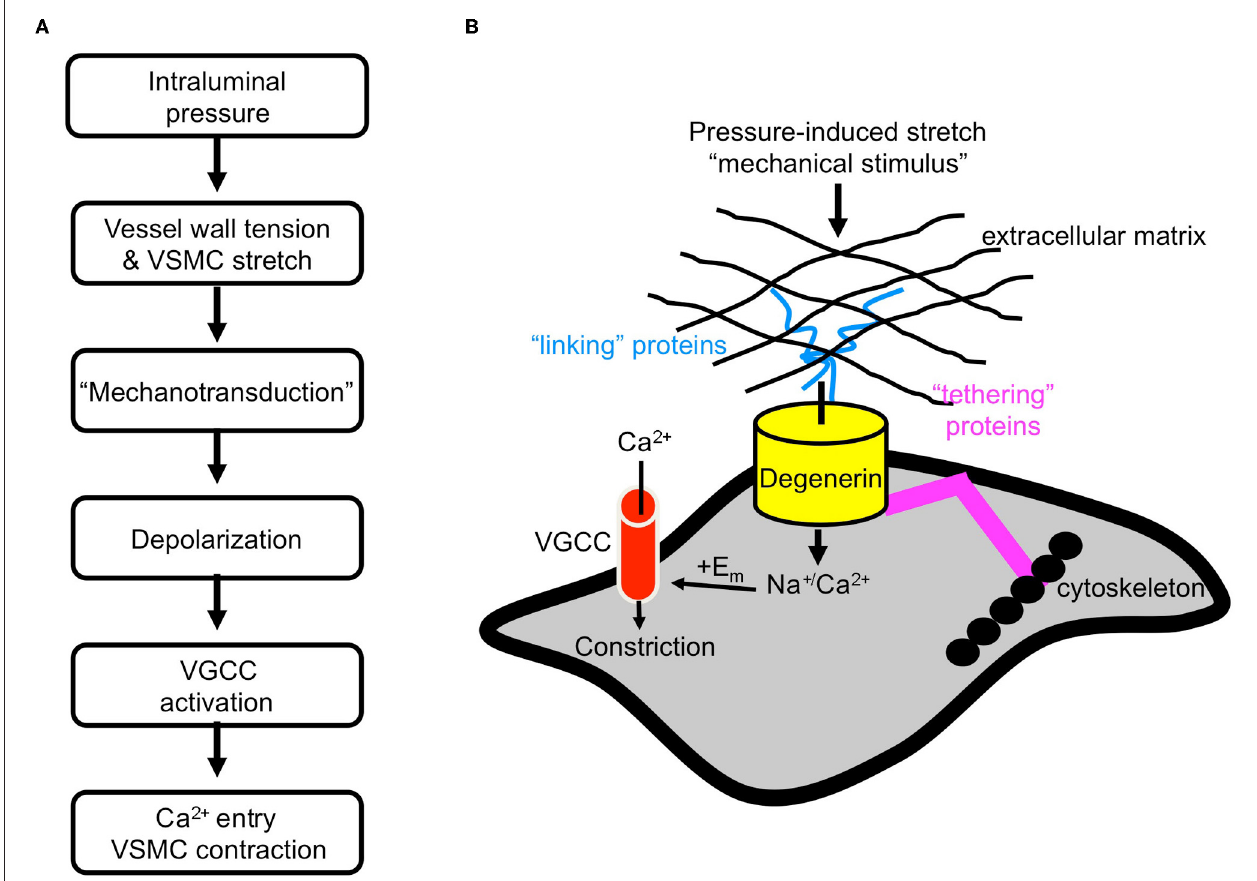
FIGURE 1 | Initiation of the myogenic response. (A) The sequence of events leading myogenic constriction. (B) Hypothetical role of degenerin proteins as a mechanotransducer in